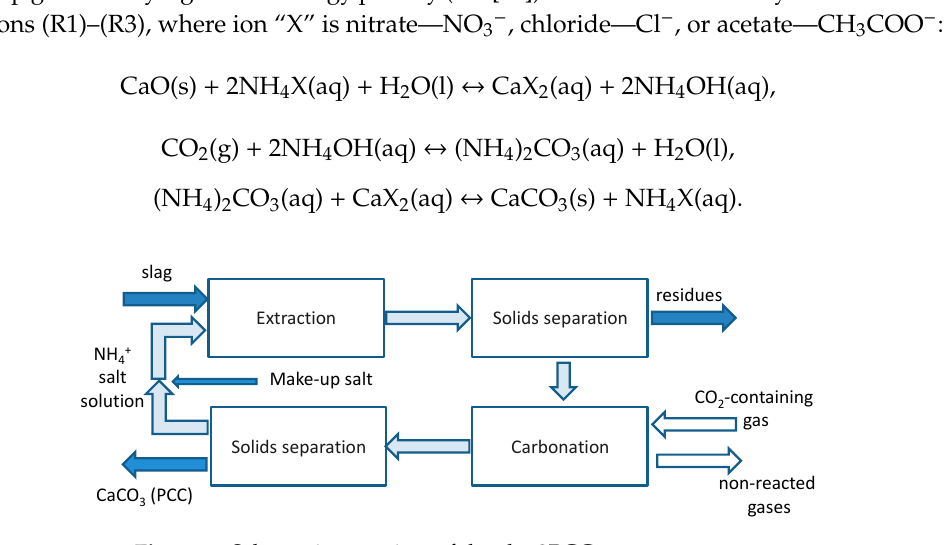
Figure 2. Schematic overview of the slag2PCC process concept.